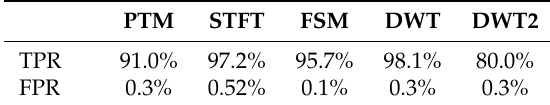
Table 7. Performance of step counting (Group